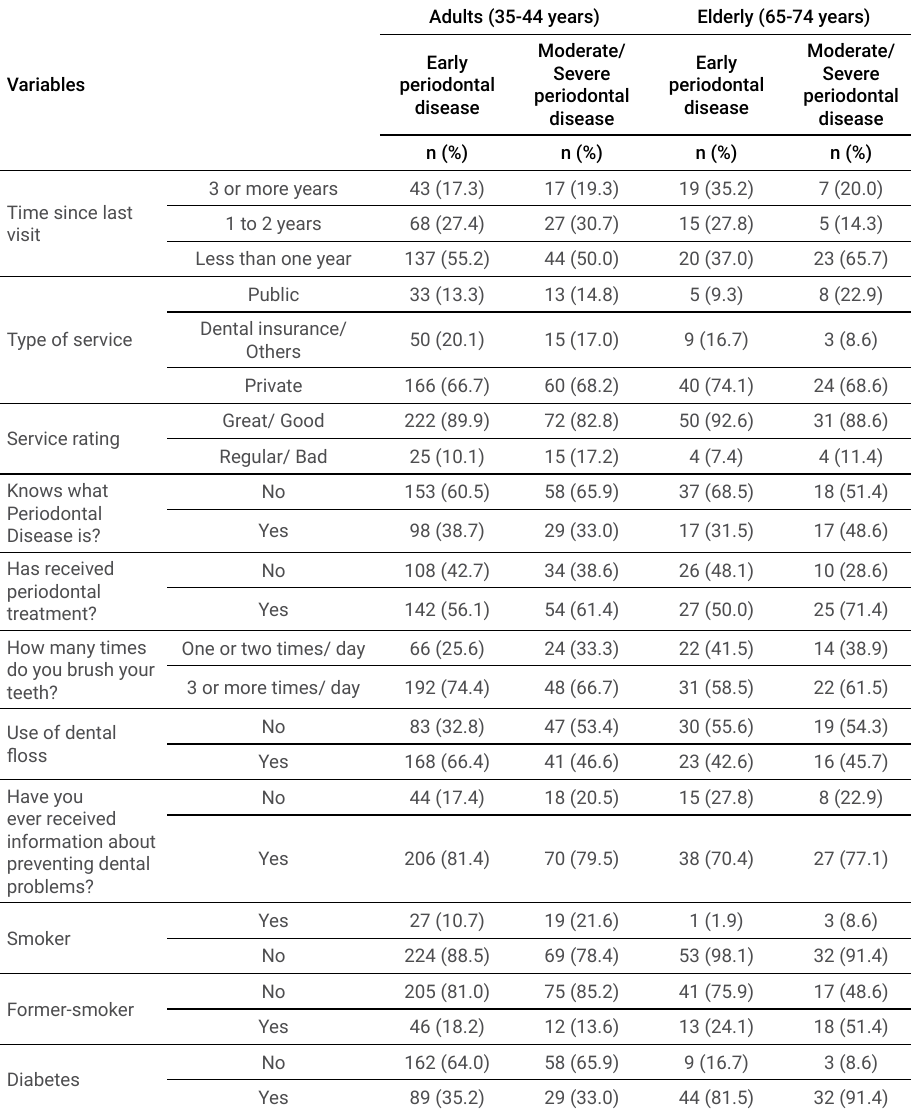
Table 2. Distribution of periodontal conditions according to dental service, behavioral and diabetes factors in adult and elderly populations from Jundiaí City.